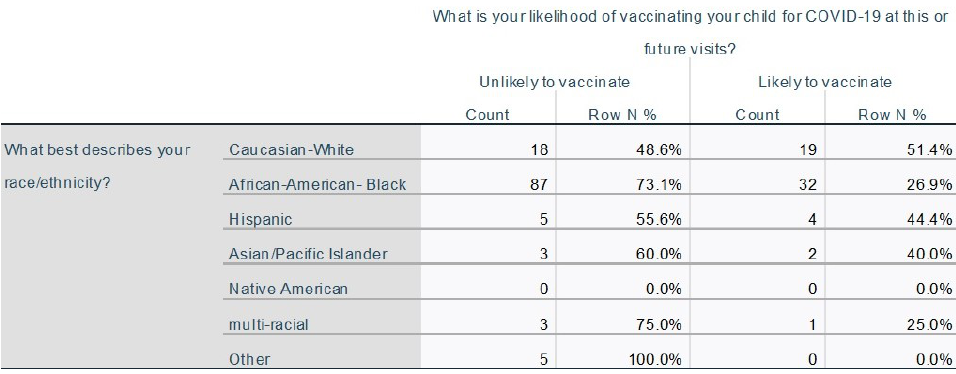
Figure 2. Describes association between an individual’s ethnicity and their likelihood to vaccinate. Parental concern for their child catching COVID-19 was assessed for the ‘unlikely to vaccinate’ and ‘likely to vaccinate’ groups (Figure 3). There was a statistically significant difference between the two groups, with the ‘unlikely to vaccinate’ group displaying a bimodal concern for their child’s COVID-19 susceptibility ( p = 0.012). Individuals who were more concerned about their child catching COVID-19 were more likely planning to vaccinate their children in the future ( p = 0.012). There was no statistical difference for the concern of one’s child catching COVID-19 between African-American and Caucasian groups ( p = 0.41).